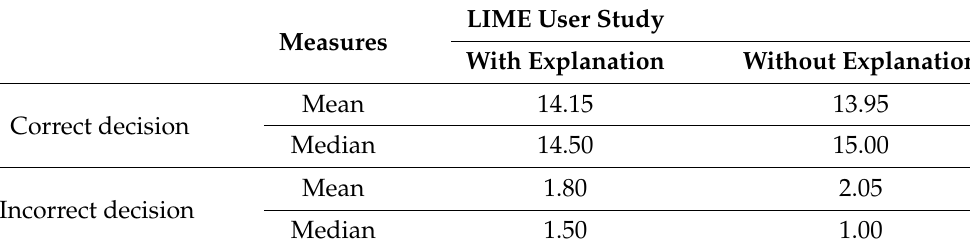
Table 6. Mean and median values of LIME users’ decision-making.